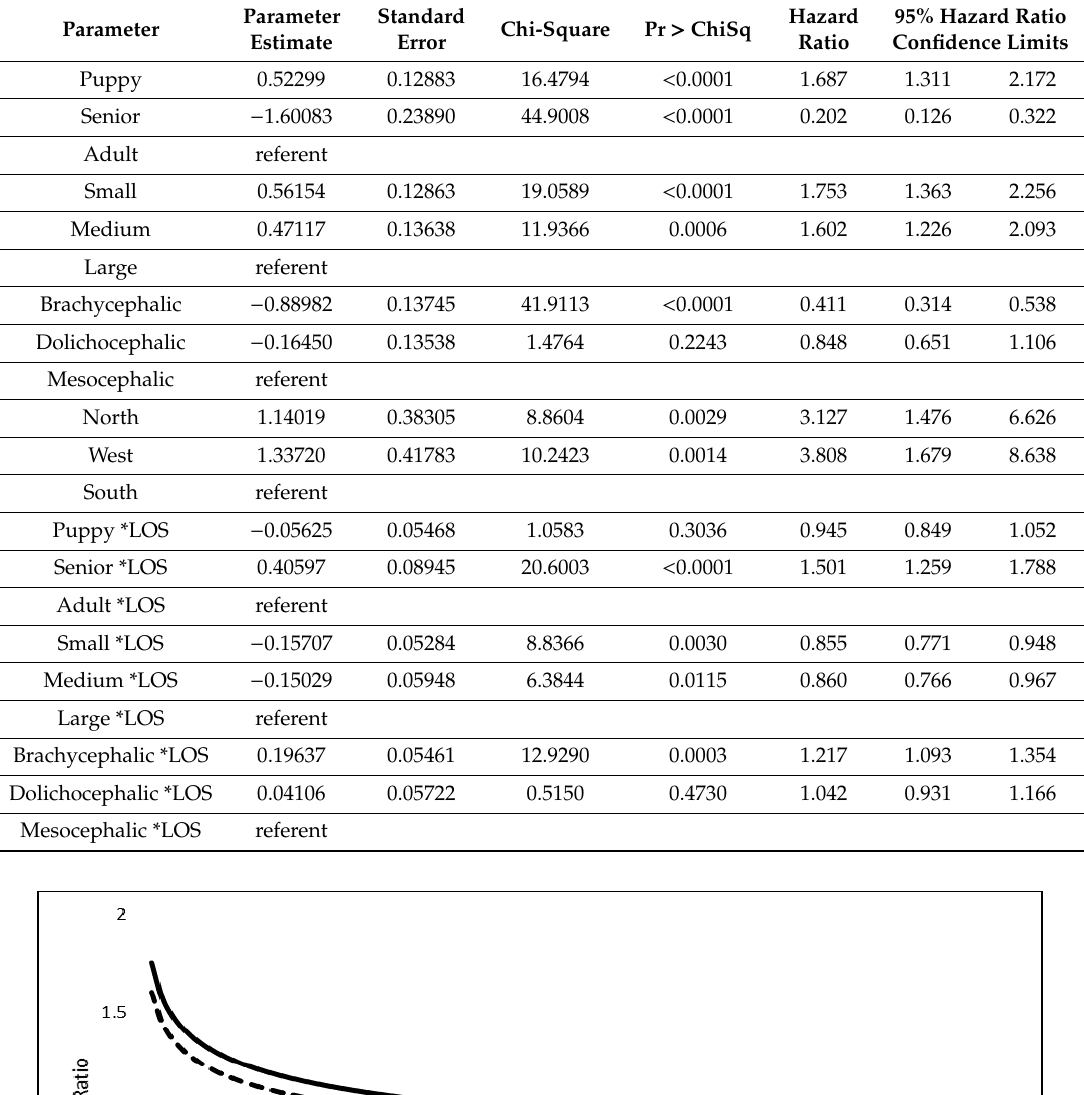
Table 2. Extended Cox regression model for adoption using the simple random sample of 4500 dogs including time interactions, indicated by length of stay (*LOS), for variables failing to meet model assumptions.